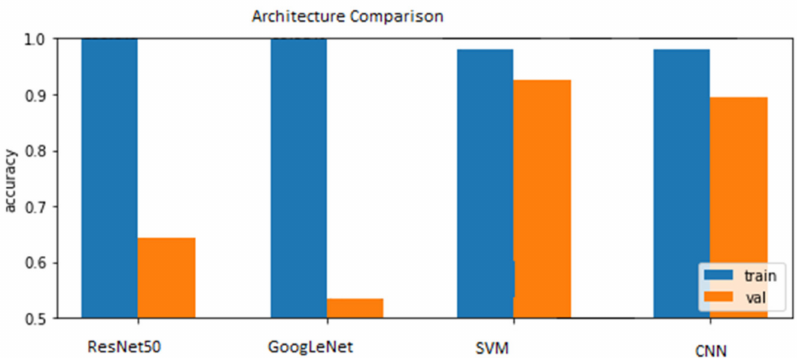
Figure 16. Bar plot for comparison of accuracies on real-life